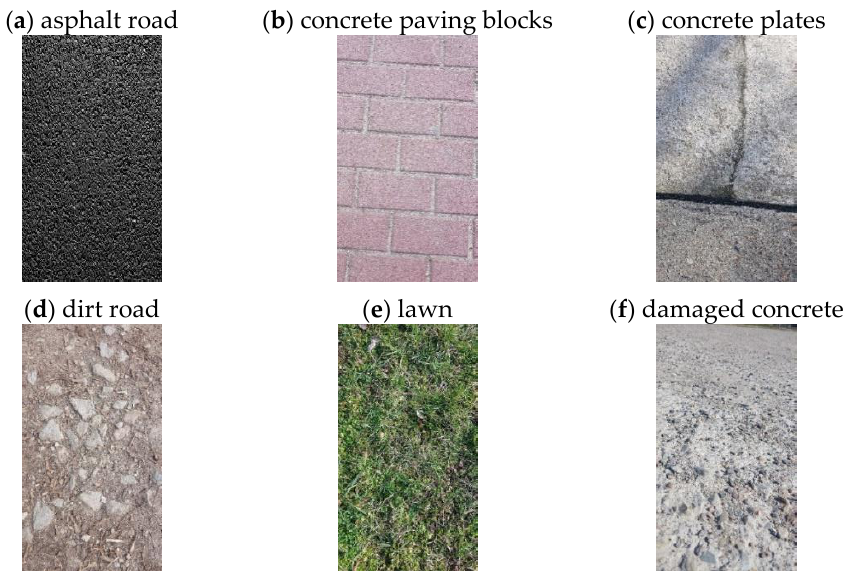
Figure 2. The surfaces on which the research was conducted.